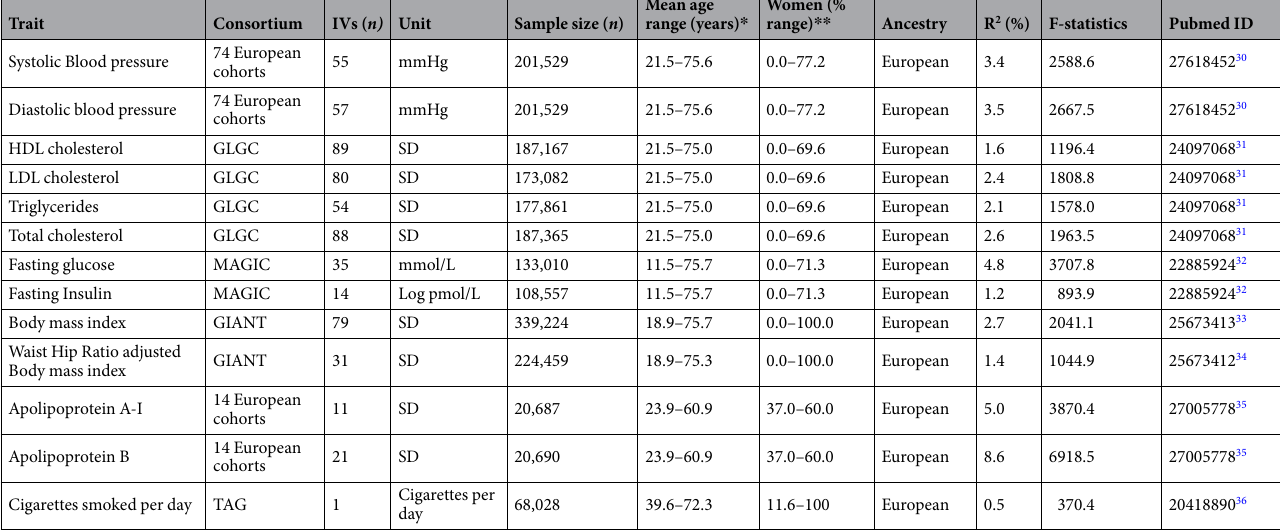
Table 2. SNPs associated with cardiovascular risk factors. HDL = High Density Lipoprotein; LDL = Low Density Lipoprotein. * Range of the mean age of the participants included in the individual studies of the GWAS meta-analysis. ** Range of the percentage of women included in the individual studies of the GWAS meta-